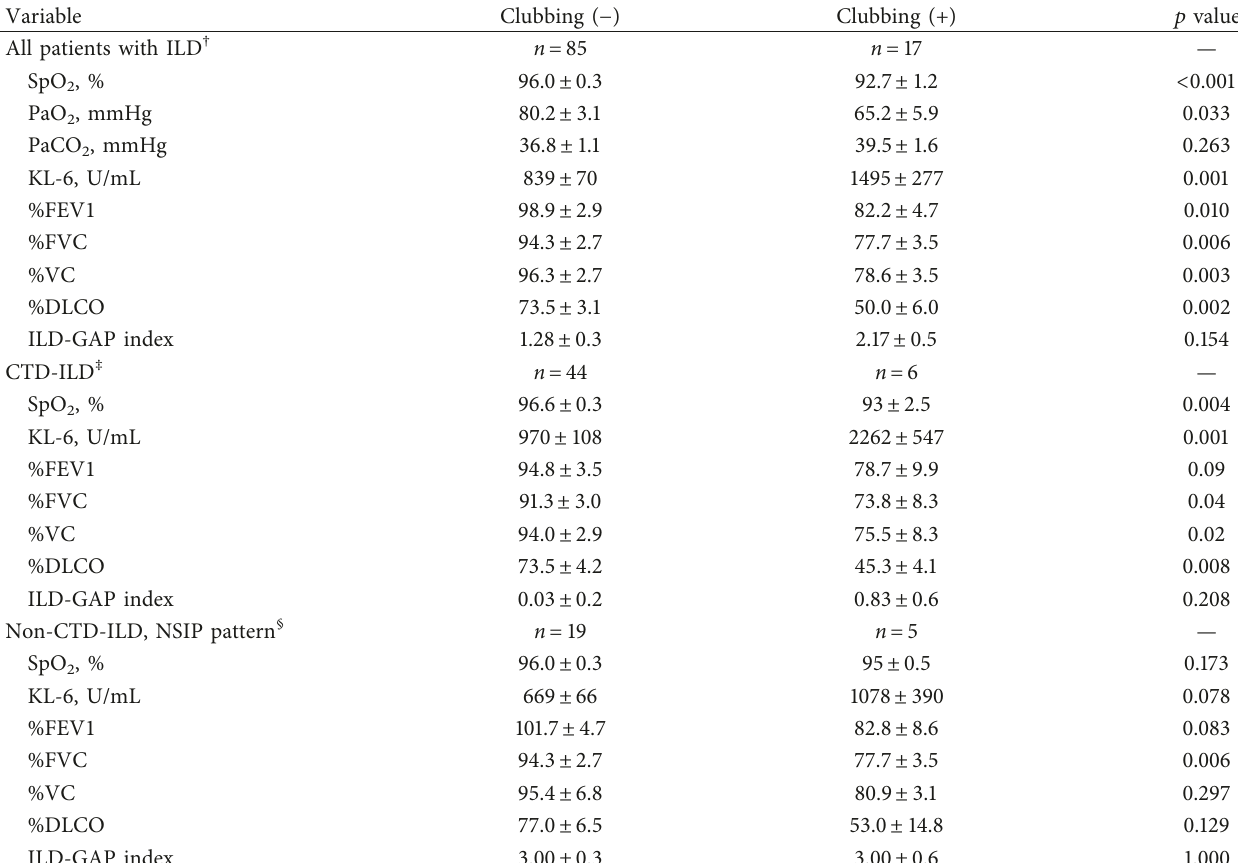
Table 3: Clinical data analysis between patients with and without